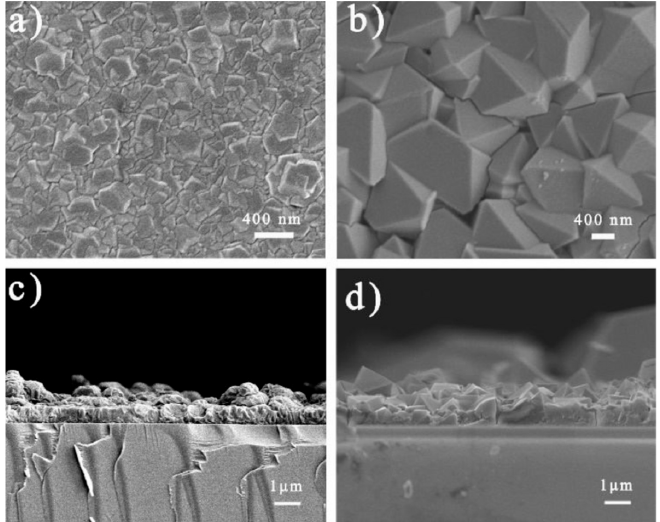
Figure 6. SEM images of ( a ) a top view and ( c ) a cross section of UiO-66-NH 2 film; SEM images of ( b ) a top view and ( d ) a cross section of Eu-BDC-NH 2 film. Reprinted with permission from Reference [62]. Copyright 2018 Elsevier.